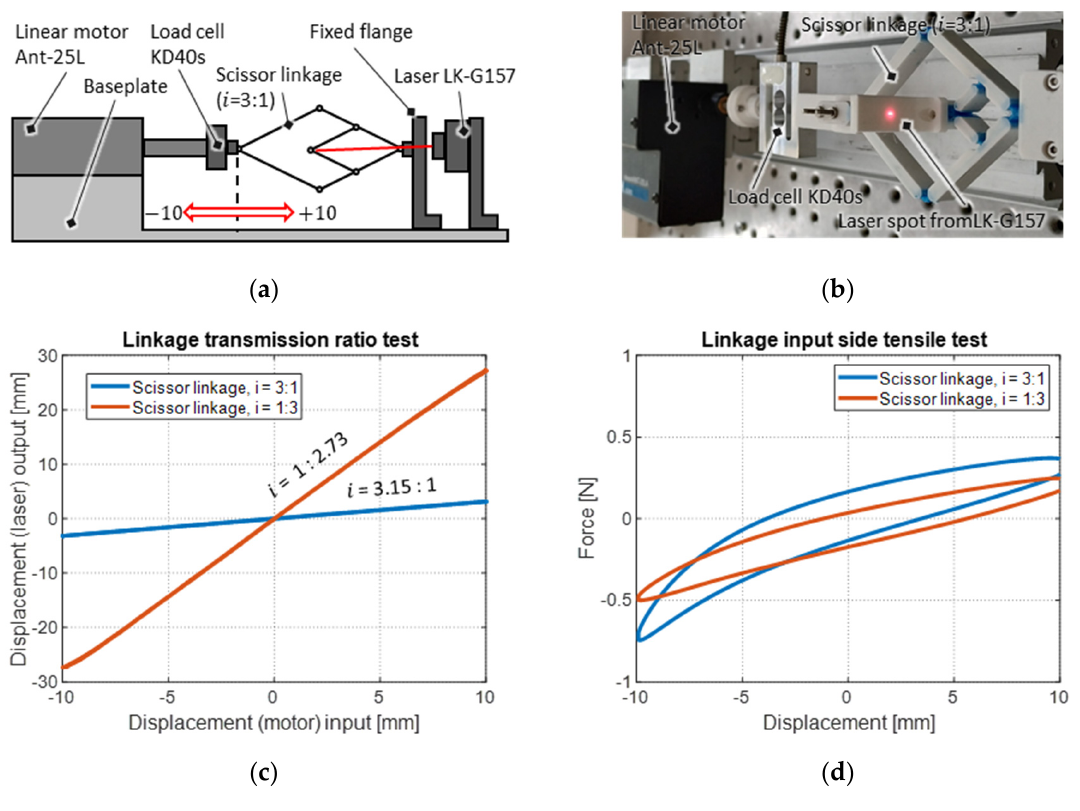
Figure 12. Illustration of the setup for the characterization of the scissor linkage mechanisms: ( a ) schematic, ( b ) photo, ( c ) measurement results for the stroke transmission factor, ( d ) results for the reaction force measured on the input side.